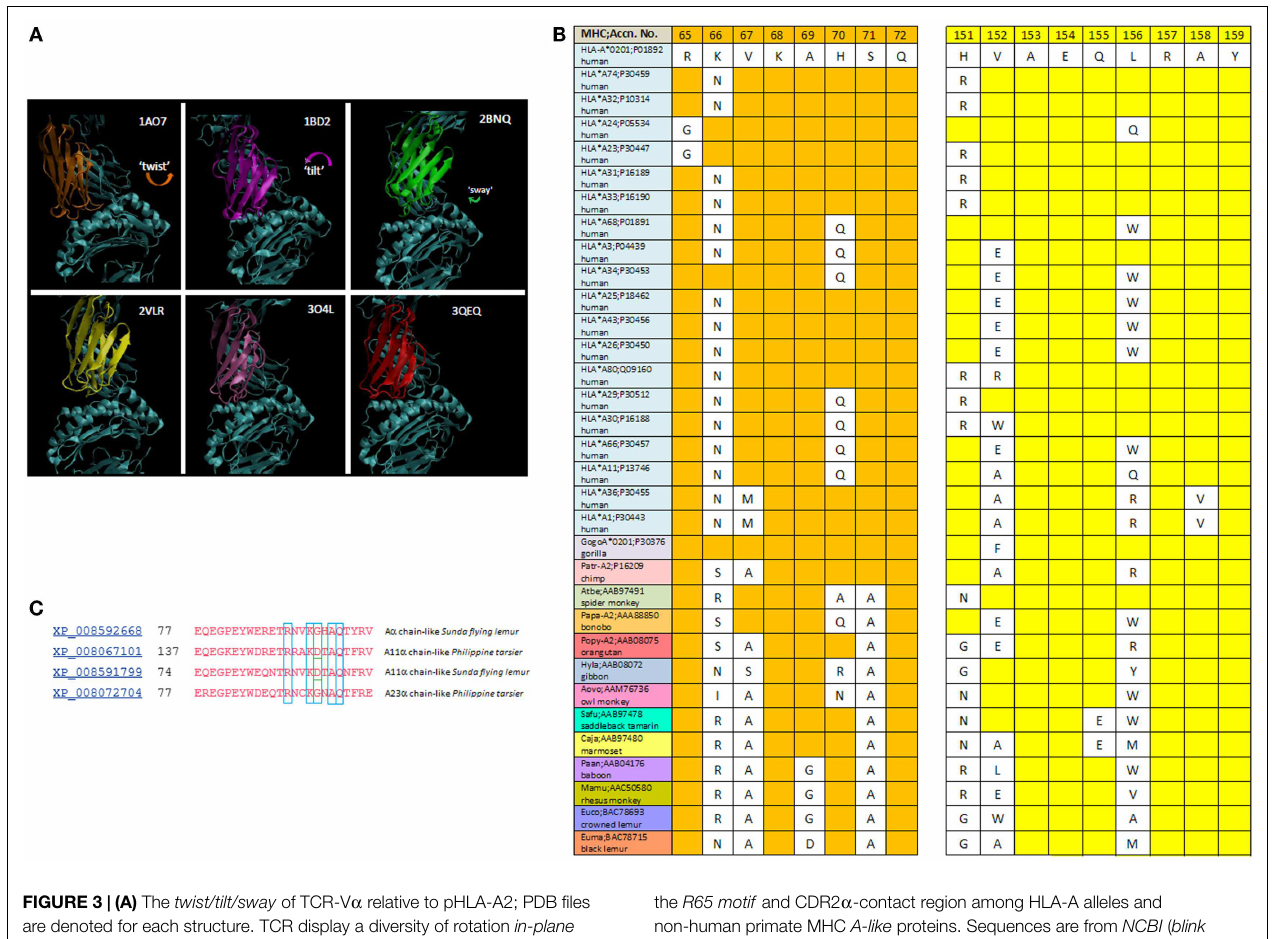
FIGURE 3 | (A) The twist/tilt/sway of TCR-V α relative to pHLA-A2; PDB files are denoted for each structure. TCR display a diversity of rotation in-plane to the groove {twist} with or without rotation perpendicular to the groove {tilting}; and this includes parallel (side-to-side) variation {sway}. V α of each different TCR are colored; V β and pHLA-A2 are in cyan. (B) Alignment of